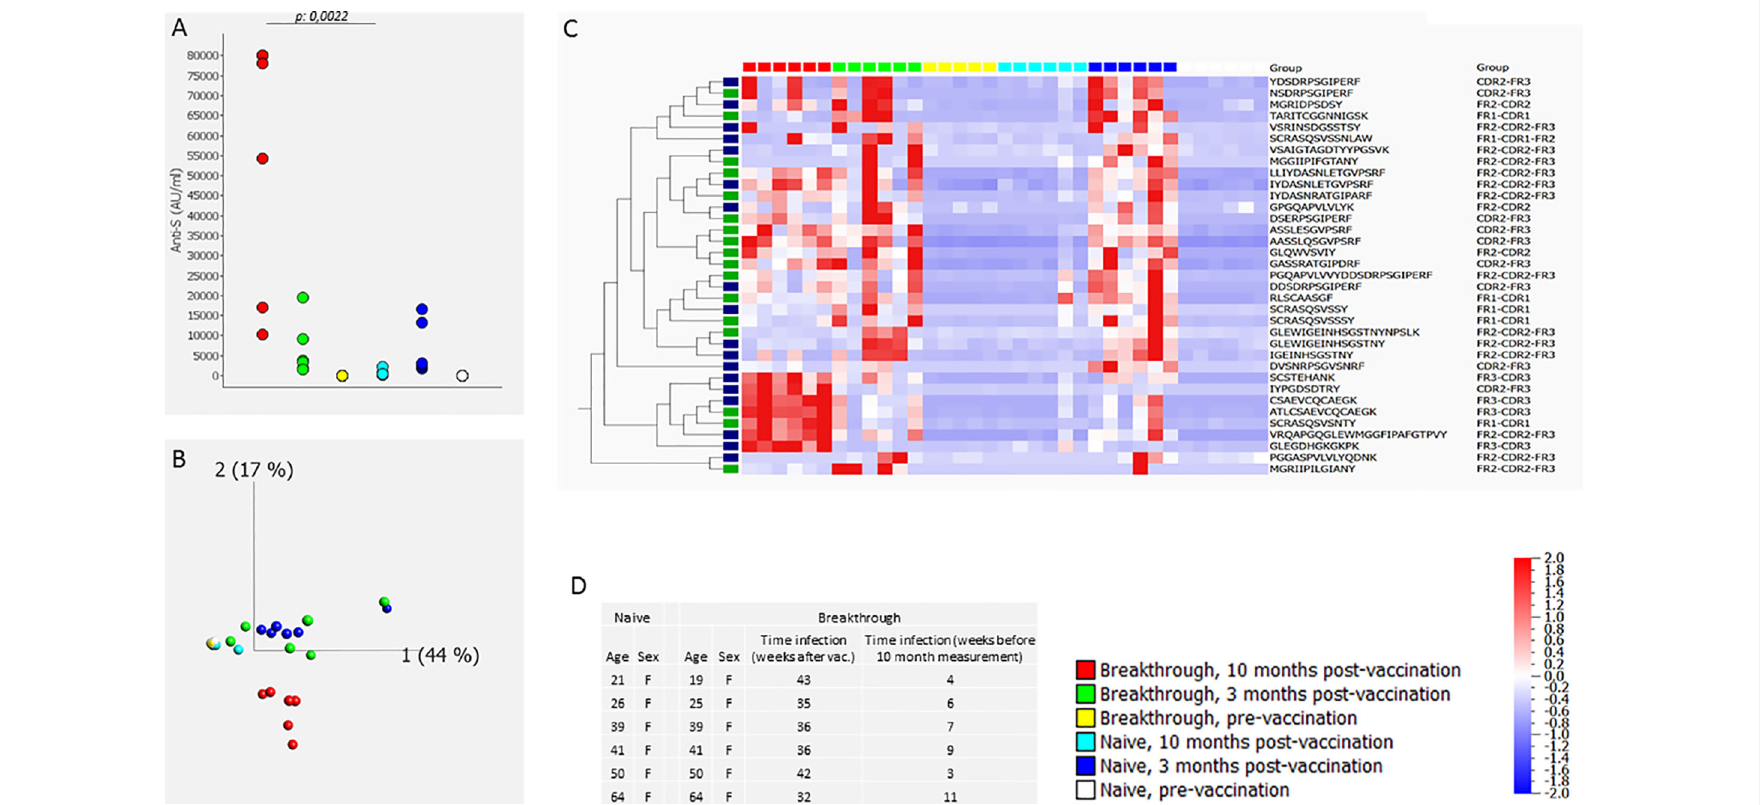
FIGURE 2 CDR pro fi le and anti-S antibodies before, 3 months and 10 months after BN162b2 vaccination (two doses) in naive individuals and in individuals that experienced a breakthrough infection between 3 and 10 months after vaccination (experiment #3). The fi gure shows the anti-S antibody levels (A) , the PCA analysis (B) , heat map after hierarchical clustering of the CDR features (C) and age and gender distribution with timing of the breakthrough infection of the included individuals (D) . The heat map indicates the variance (from -2 to 2) compared to the mean (0) for each peptide feature. The included vaccination/infection-induced CDR-derived peptides were those that revealed discriminative by sPLS-DA analysis. The green-labeled CDR-derived peptides were also revealed discriminative by sPLS-DA analysis in experiment #4 (Extended Data Figure 4). The median [25 th -75 th percentile] anti-S antibody levels (AU/mL) were 2 [0.2-3.47], 2914 [2453-10717] and 374 [278-531], 2 [0.5-2.7], 3621 [2152-7819], 66209 [26454-79519], pre-vaccination no breakthrough, post- vaccination 3 months no breakthrough, post-vaccination no breakthrough, pre-vaccination breakthrough, post-vaccination 3 months breakthrough, post-vaccination breakthrough,